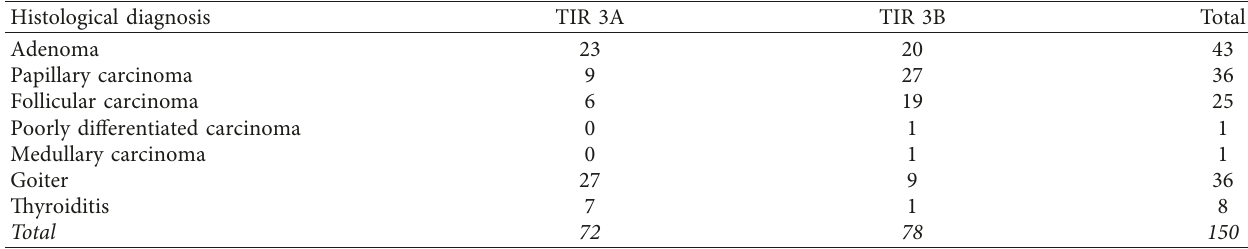
Table 3: Final histological diagnosis associated with the relative cytological reports.